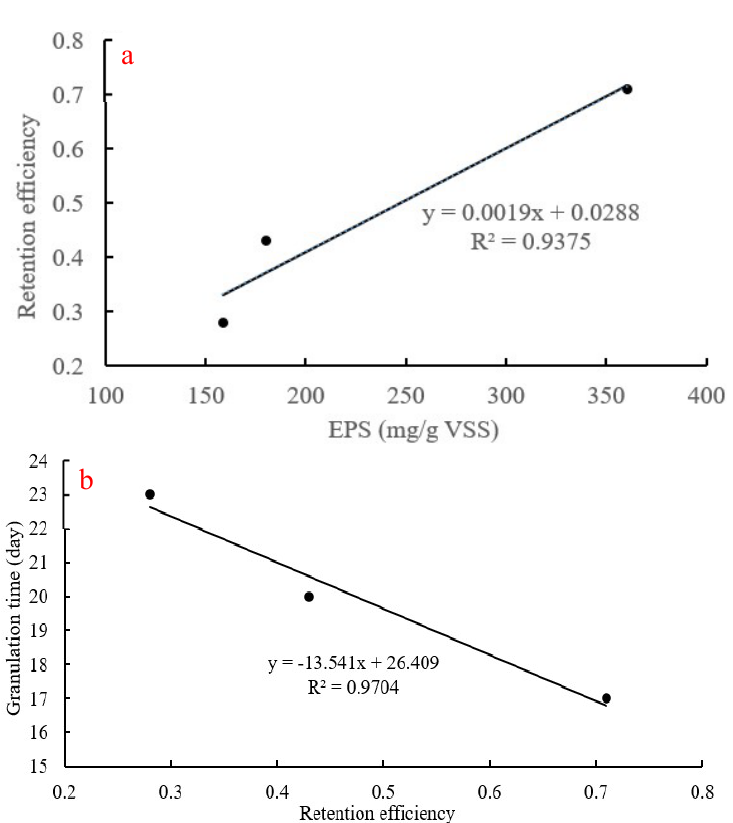
Figure 6. Relationship between ( a ) aggregates retention efficiency and ( b ) between retention efficiency and granulation time. Table 3. Studies testing the efficiency of the rapid granulation process using effluent sludge external conditioning followed by its reintroduction into SBR .